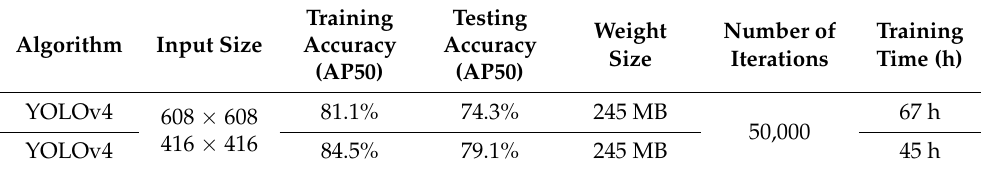
Table 3. Constructing pretrained weights using a limited